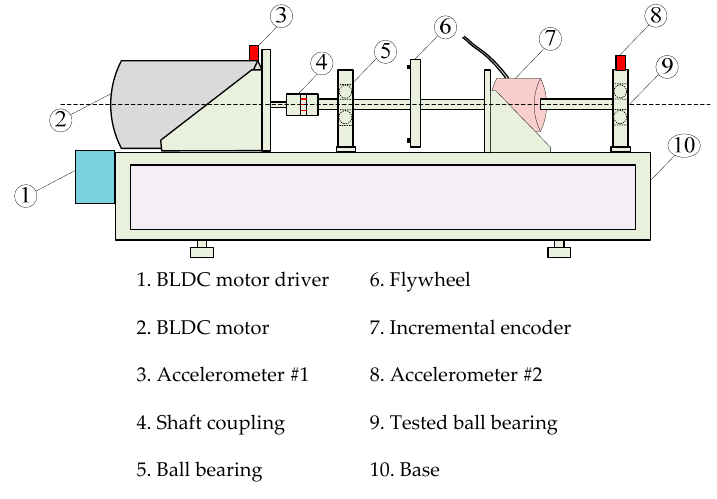
Figure 5. Schematic diagram of experimental setup.